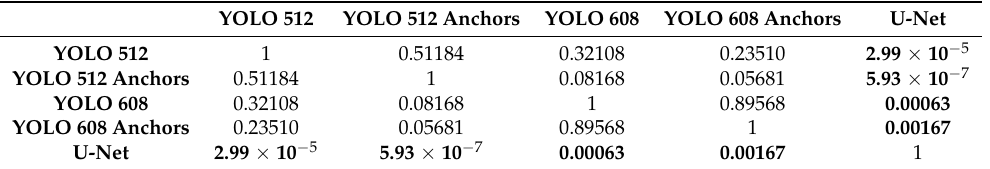
Table A1. McNemars’ test for binary evaluation of the methods. Bolded values represents statistical significance at the p < 0.01 level.